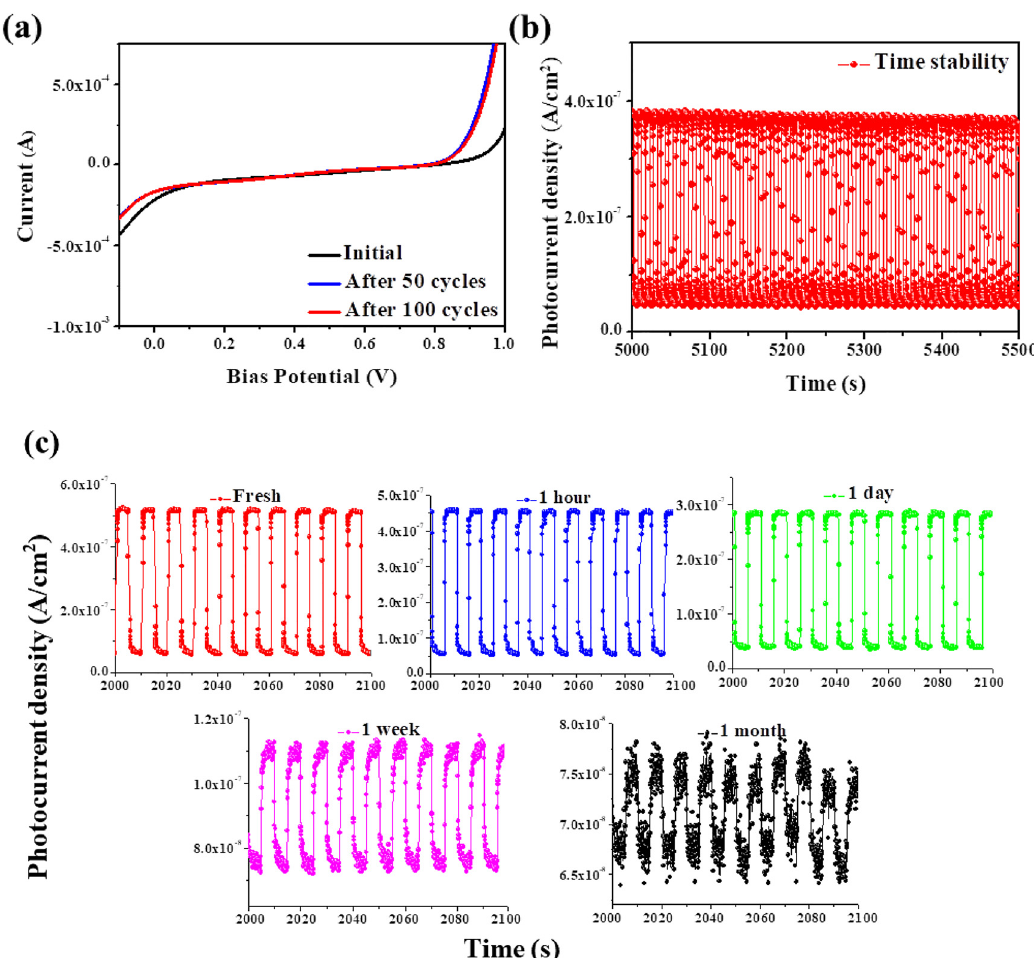
Figure5: (a)Cyclingstabilityexperimentsofgraphdiynephotodetectorin0.5MKCl.(b)Long-termphotocurrentresponsetestsofgraphdiyne nanosheets-based photodetector. (c) Time stability measurements of graphdiyne photodetector after 1 h, 1 day, 1 week and 1 month under 0.5 M